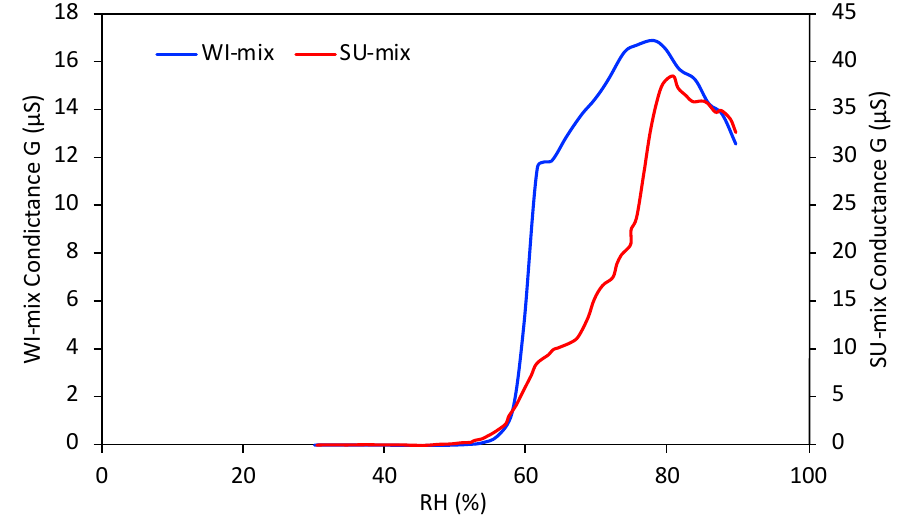
Figure 8. Electrical conductance (G) measurements during a humidity cycle (RH) in the AEC for WI-mix and SU-mix aerosol mixed with EC.